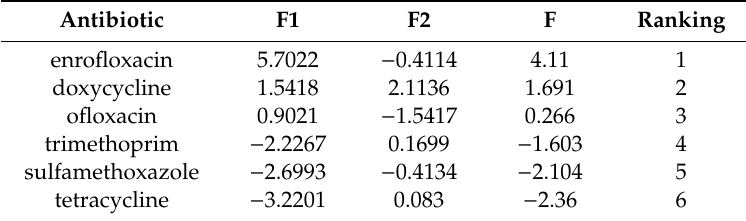
Table 5. The drug score summary in Chongqing, 2013.